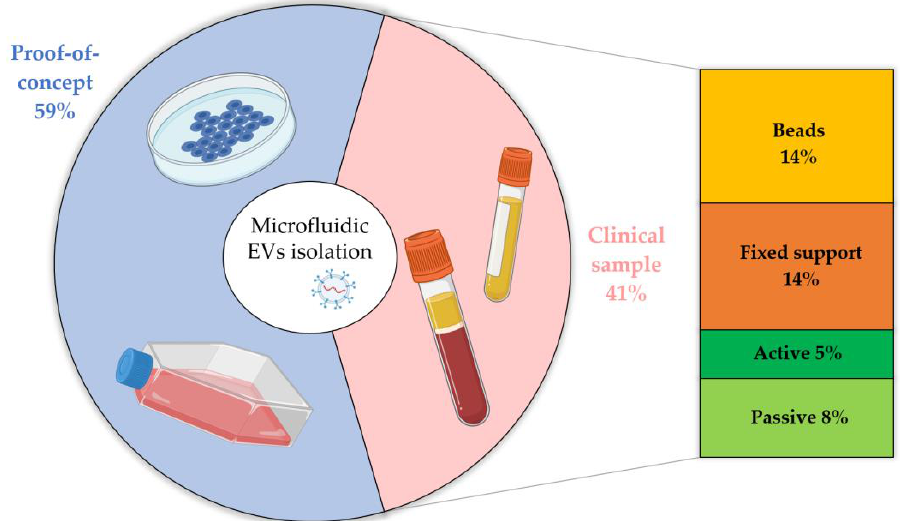
Figure 8. Frequency of published works from 2000 to present (source: Web of Science database, excluding reviews, meeting abstracts, and retracted papers) involving EV isolation from starting biofluids used as a proof of concept (cell culture media or EVs spiked in body fluids) or as clinical samples (body fluids directly employed) from healthy donors or patients for research studies or diagnostic purposes, further divided according to the isolation technique.